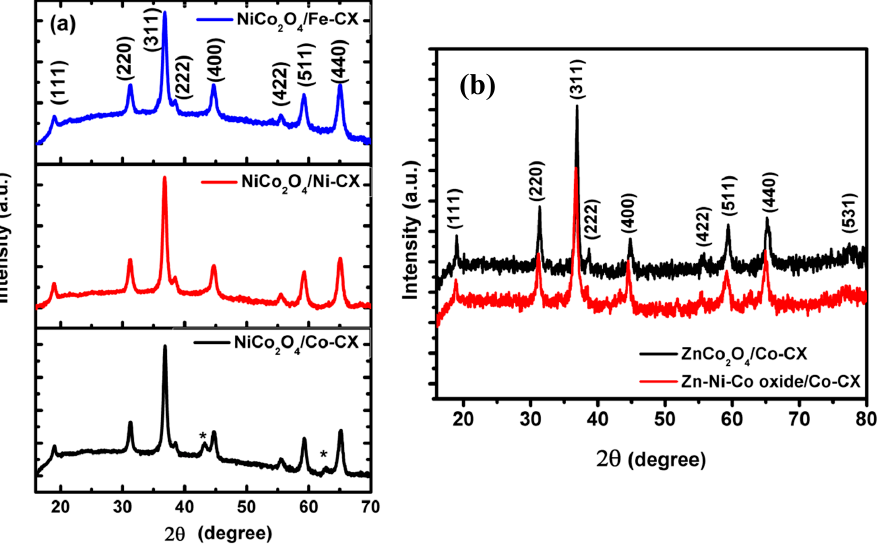
Figure 2. XRD pattern for ( a ) NiCo 2 O 4 / M-CX and ( b ) ZnCo 2 O 4 / Co-CX and Zn-Ni-Co oxide /